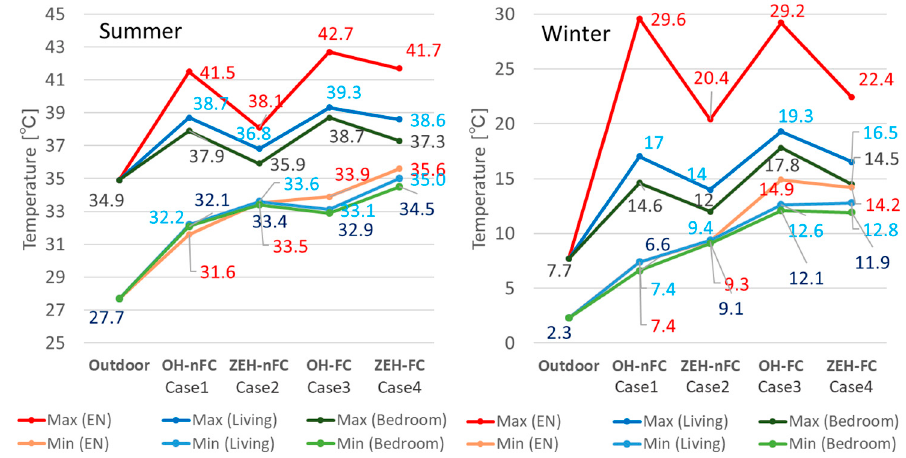
Figure 7. Max and Min temperatures (left: summer, right: winter).